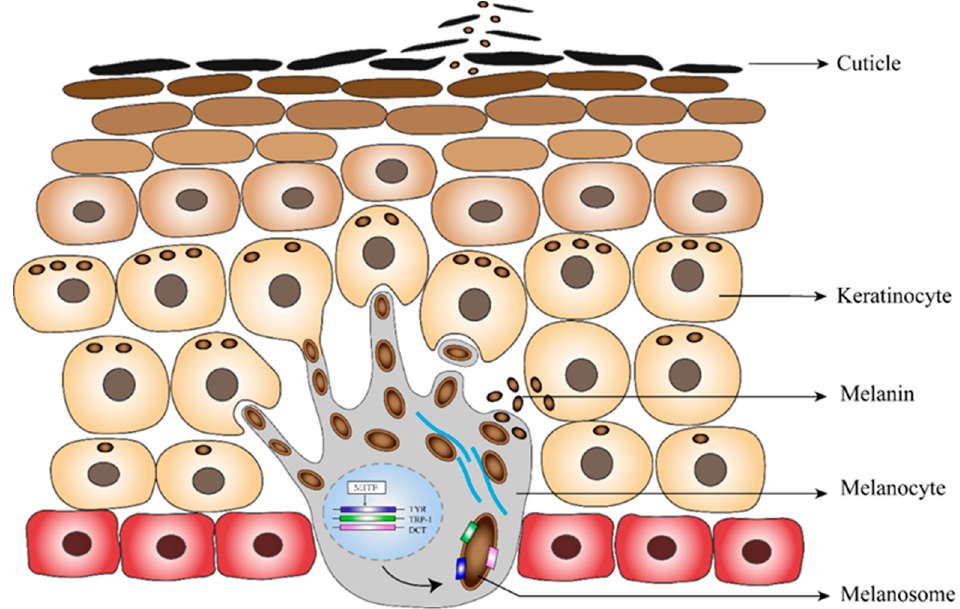
Figure 4. Putative formation of the black skin secretion.